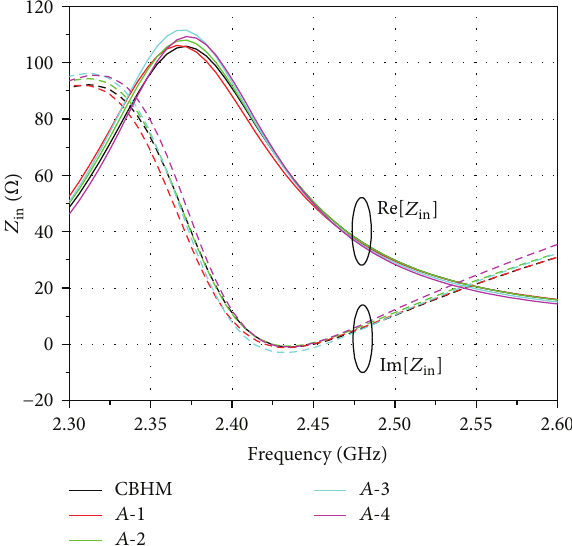
Figure 12: Reflection coefficient magnitudeand CPLH-Pof theSIW antenna.